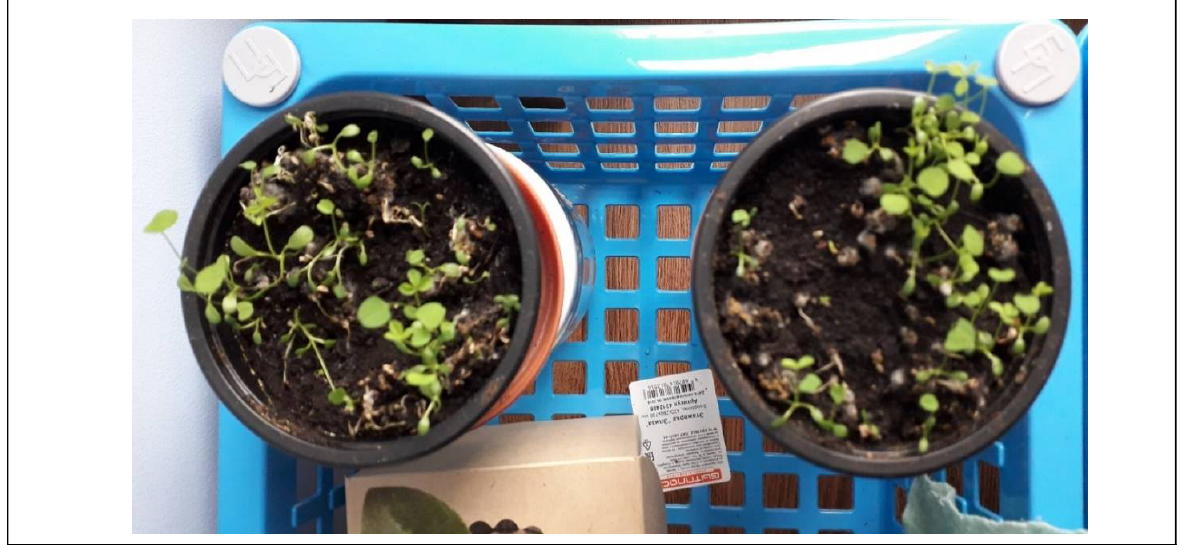
Figure 4: On the left is ordinary water, on the right is magnetized water (May 2, 2019)